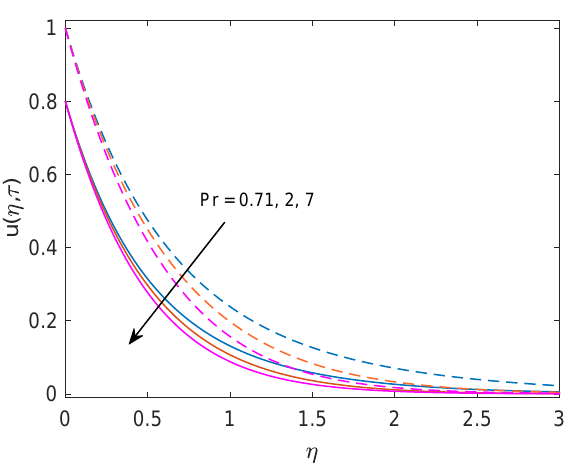
Figure 7. Effect of different values of